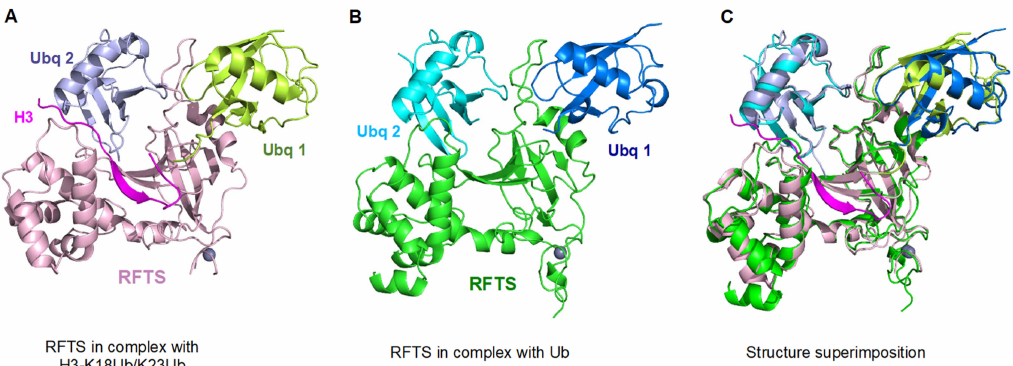
Figure 3. The DNMT1 RFTS domain is a dual mono-ubiquitinated histone H3 binding module. ( A ) Crystal structure of DNMT1 RFTS in complex with ubiquitinated histone H3 (PDB: 5WVO) [57]. ( B ) Crystal structure of DNMT1 RFTS in complex with ubiquitin (PDB: 5YDR) [58]. ( C ) The interaction between RFTS and ubiquitin is essentially the same in these structures. Superimposition of two complex structures gives an RMSD of